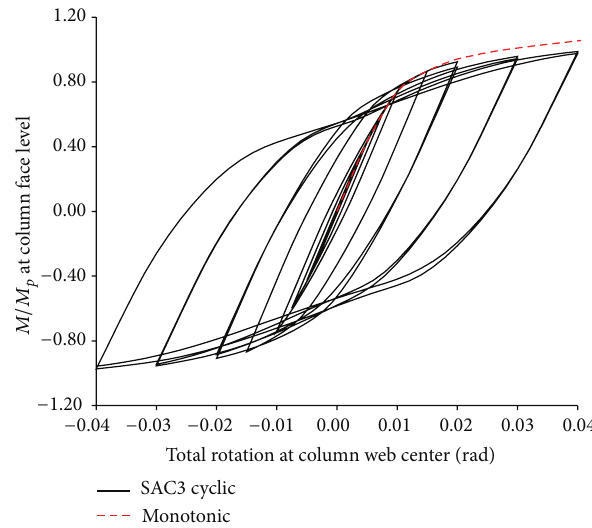
Figure 15: Normalized moment rotation curve of specimen SAC7 for 𝛼 = 2 , 𝛽 = 0.75 , and 𝛾 = 0.1 .